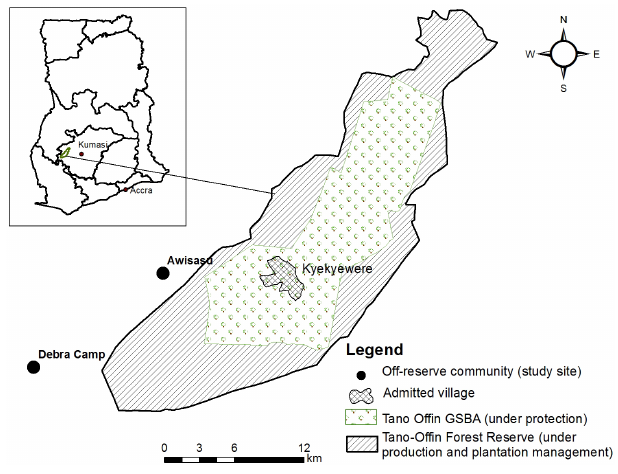
Fig. 2. Map of the study communities Awisasu and Debra Camp bordering Tano-Offin Forest Reserve,